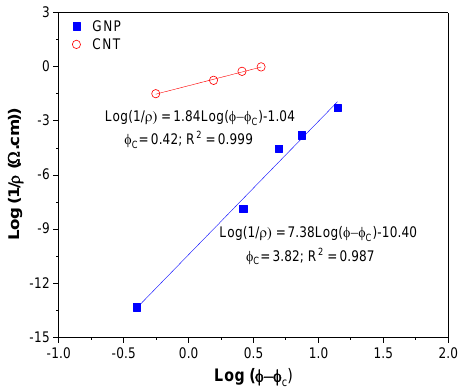
Figure 9. Resistivity of composites as function of filler volume fraction and calculated percolation threshold according to power law fit from Equation (20).